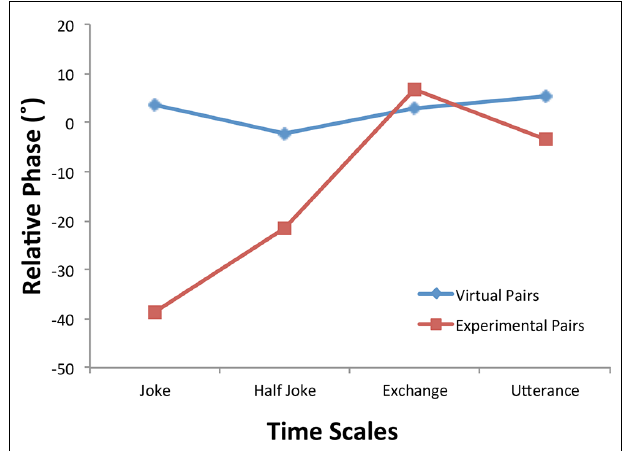
FIGURE 6 |Wavelet mean relative phase angle at the four joke time scales for the virtual and experimental participant pairs.